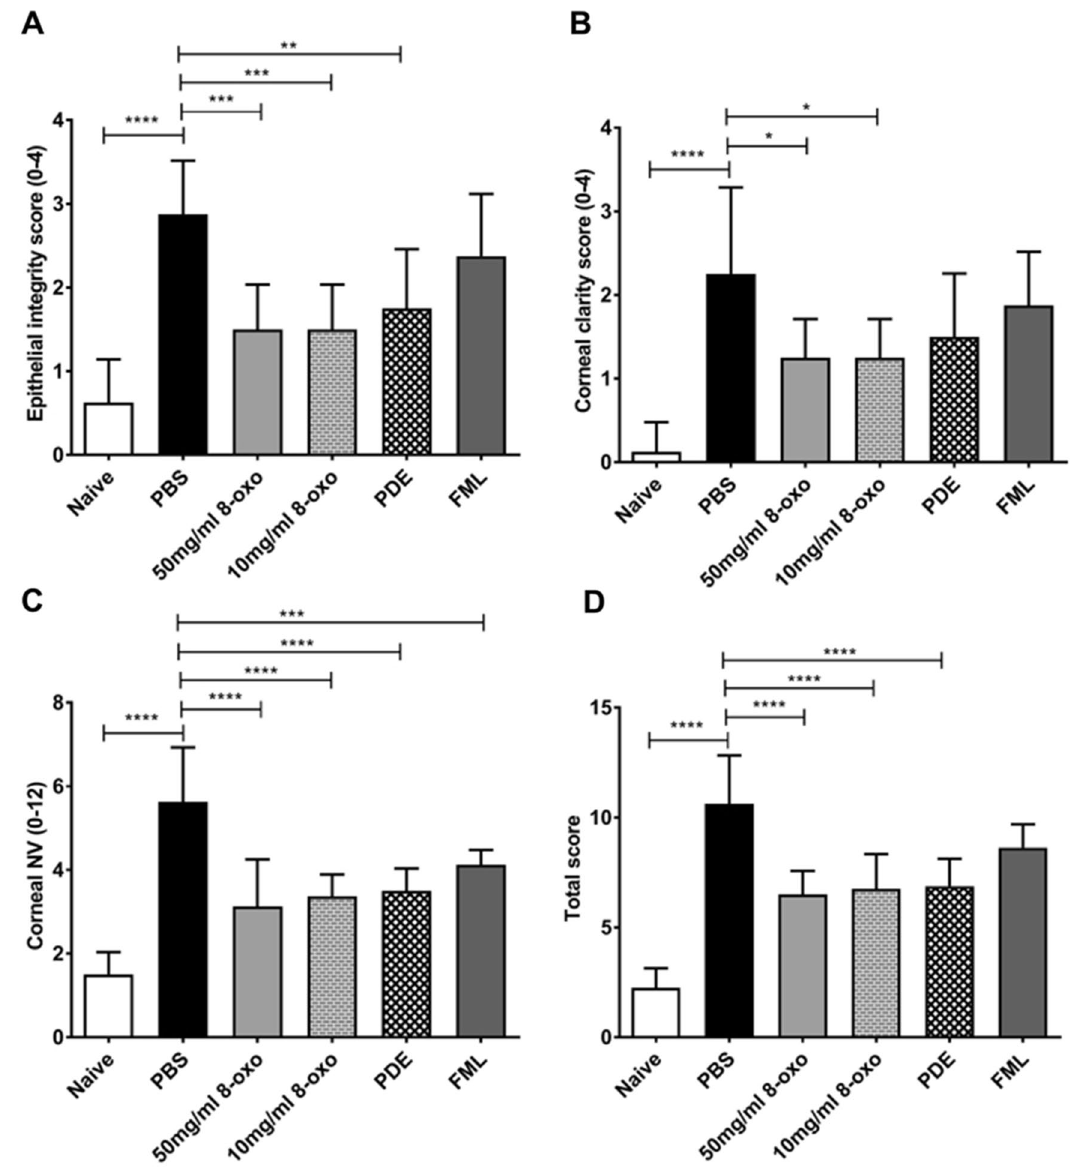
Figure 2. Clinical scores 1 week after treatment of ocular alkali burn model with topical 8-oxo-2 ′ - deoxyguanosine (8-oxo-dG) or corticosteroid. ( A ) Epithelial integrity score, ( B ) corneal clarity score, ( C ) corneal neovascularization score, and ( D ) total score. Data are means ± standard error of the mean (SEM). * p < 0.05, ** p < 0.01, *** p < 0.001, and **** p < 0.0001. 8-oxo: 8-oxo-dG. PBS phosphate-buffered saline, PDE prednisolone acetate 1% (10 mg/mL), FML fluorometholone 0.1% (1 mg/mL), NV therapeutic effects. In addition, stromal edema, inflammatory cell infiltration, and expression of inflammatory cytokines and oxidative stress-related molecules were significantly decreased after treatment with 8-oxo-dG, and these effects were comparable with those of the corticosteroid. Repeated administration of topical 8-oxo-dG showed no remarkable effects on the cornea and did not induce significant weight changes. DNA damage induced by ROS readily transforms guanine into 8-oxo-7,8-dihydroguanine (8-oxo-Gua), which is the most abundant oxidative DNA adduct 24 . In DNA, 8-oxo-Gua can have noxious effects owing to the induc- tion of transversion mutation 25 . Fortunately, cells possess relevant repair systems that protect against damage by 8-oxo-Gua. For instance, 8-oxo-Gua in DNA is removed by processes that involve base excision repair enzymes, including 8-oxo-guanine glycosylase, or by a nucleotide excision repair mechanism. Consequently, 8-oxo-dG, a nucleoside of 8-oxo-Gua, is generated from damaged oligomers, including 8-oxo-Gua, or cytoplasmic oxidized nucleotides, such as 8-hydroxy-dGTP 26,27 . Reportedly, 8-oxo-dG is membrane permeable and, thus, typically